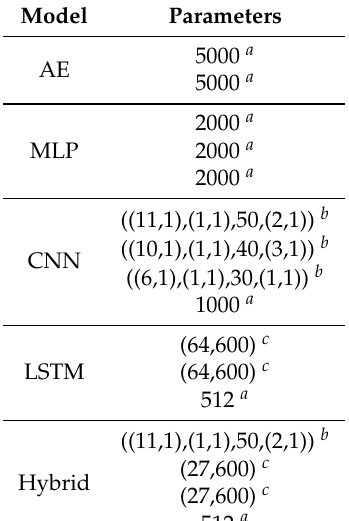
Table 6. Hyper-parameters of the learning-based methods on the OPPORTUNITY dataset and the UniMiB-SHAR